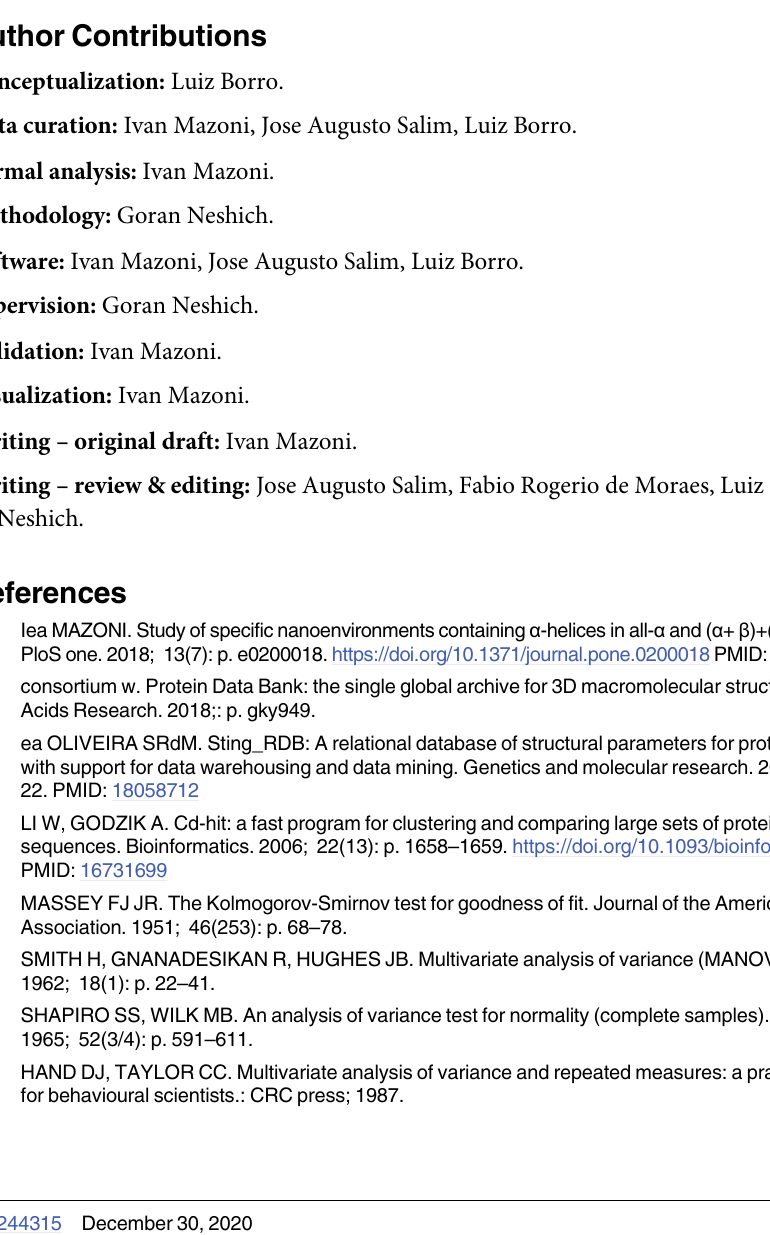
S1 Fig. Results for univariate tests using the STING_RDB descriptors for all- β parallel only, all- β anti-parallel only and one strand only nanoenvironment. S2 Fig. Results for univariate tests using the STING_RDB descriptors for β -sheet in ( α + β ) +( α / β ) parallel only, all- β anti-parallel only and one strand only